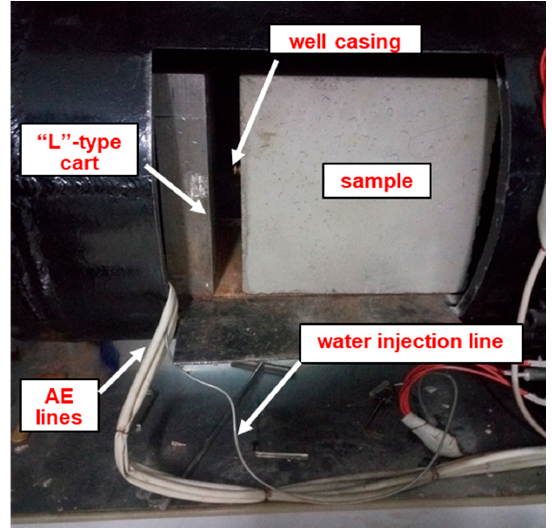
Figure 5. “L”-type cart.